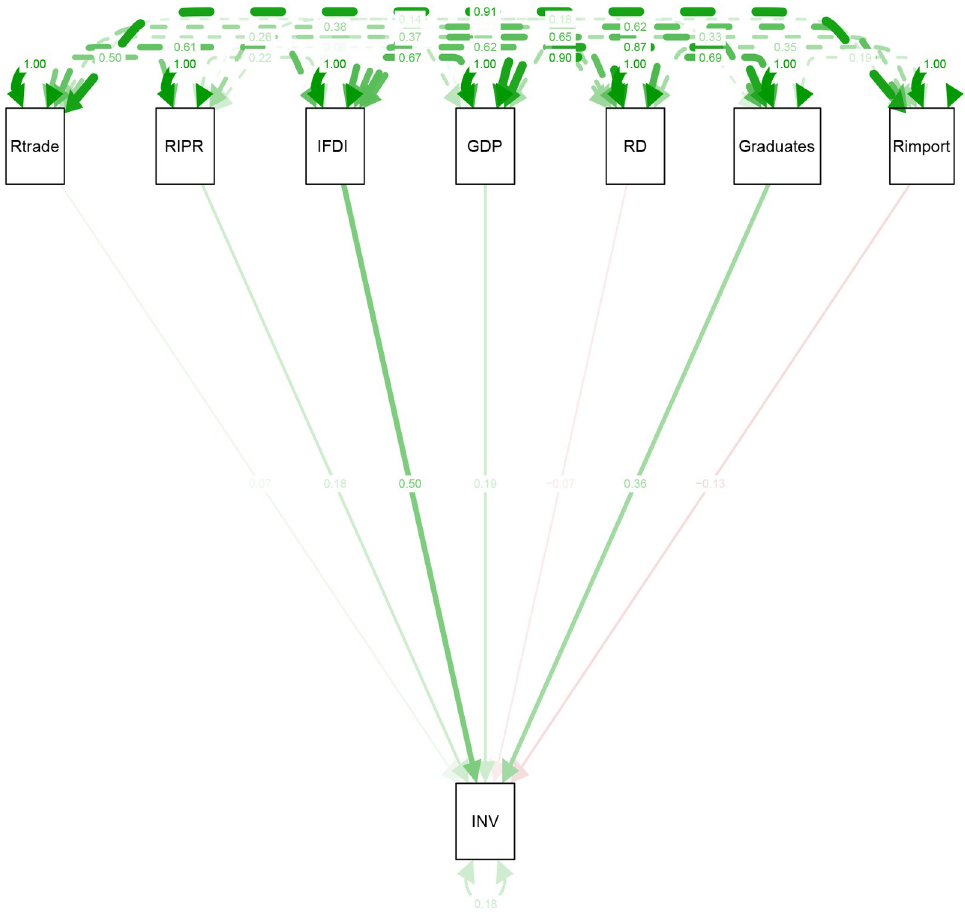
Fig 1. Causal relationship of all the variables depicted by path analysis. Source: Authors’